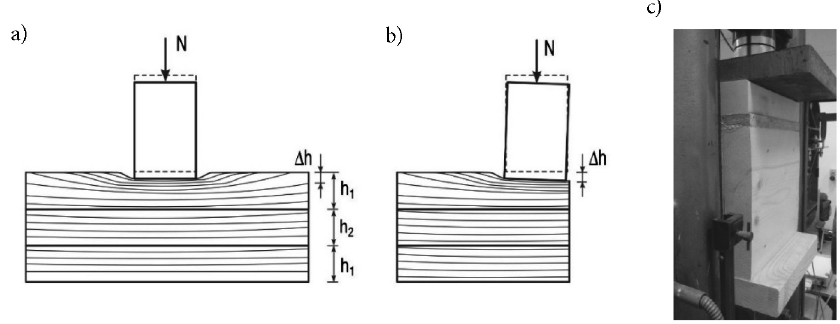
Figure 5. Deformation under compression and contact pressure: a – for interior posts; b – for terminal posts; c – evaluation of perpendicular to grain deformation of module floor elements in